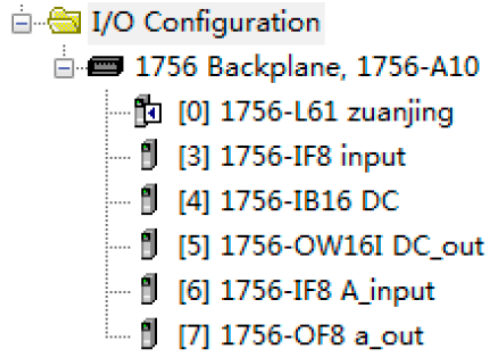
Figure 8. I/O configuration.